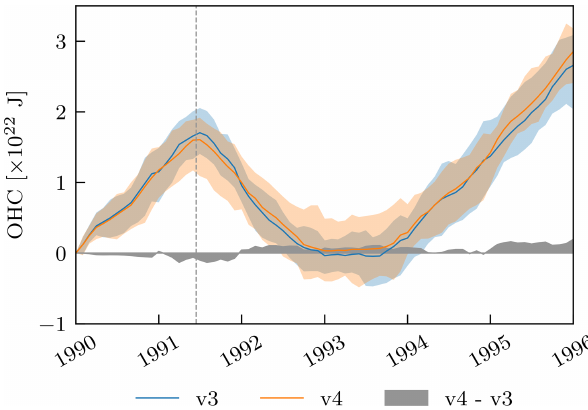
Figure 8. Monthly deseasonalized ocean heat content relative to January 1990. The blue line shows ocean heat content (OHC) using the version 3 aerosol forcing, while the orange line indicates results when using version 4. The shading indicates the 10th and 90th per- centiles of the data.